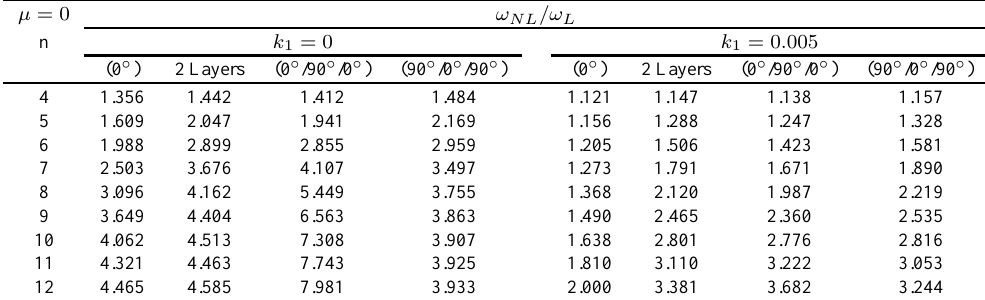
Table 9 Variation of the relative frequency with respect to the number of circumferential waves and number and ordering of layers